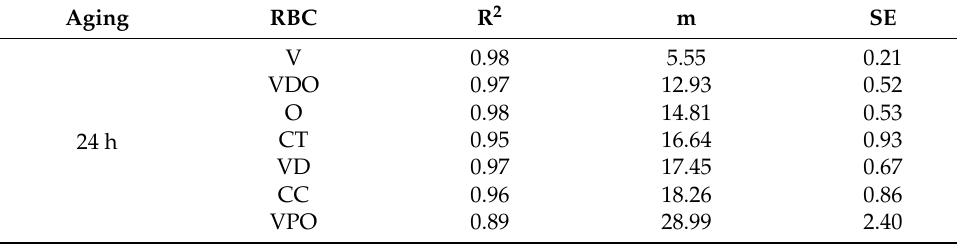
Figure 6. Variation of the Vickers hardness (HV) as a function of RBC and aging conditions (mean values with 95% confidence interval).